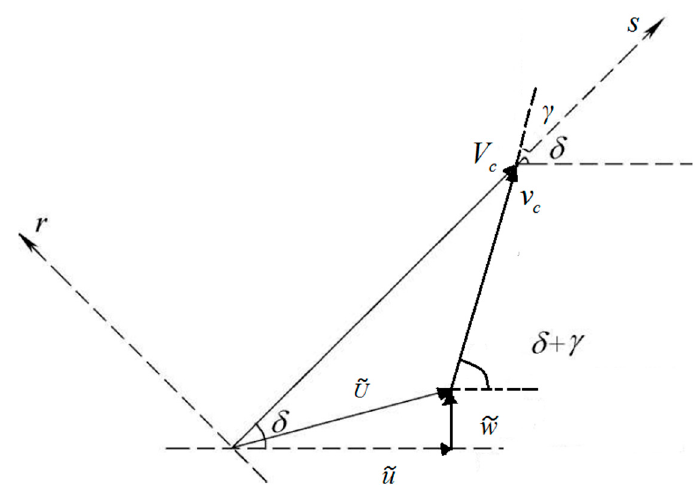
Figure 2. Geometric relationships between velocities.